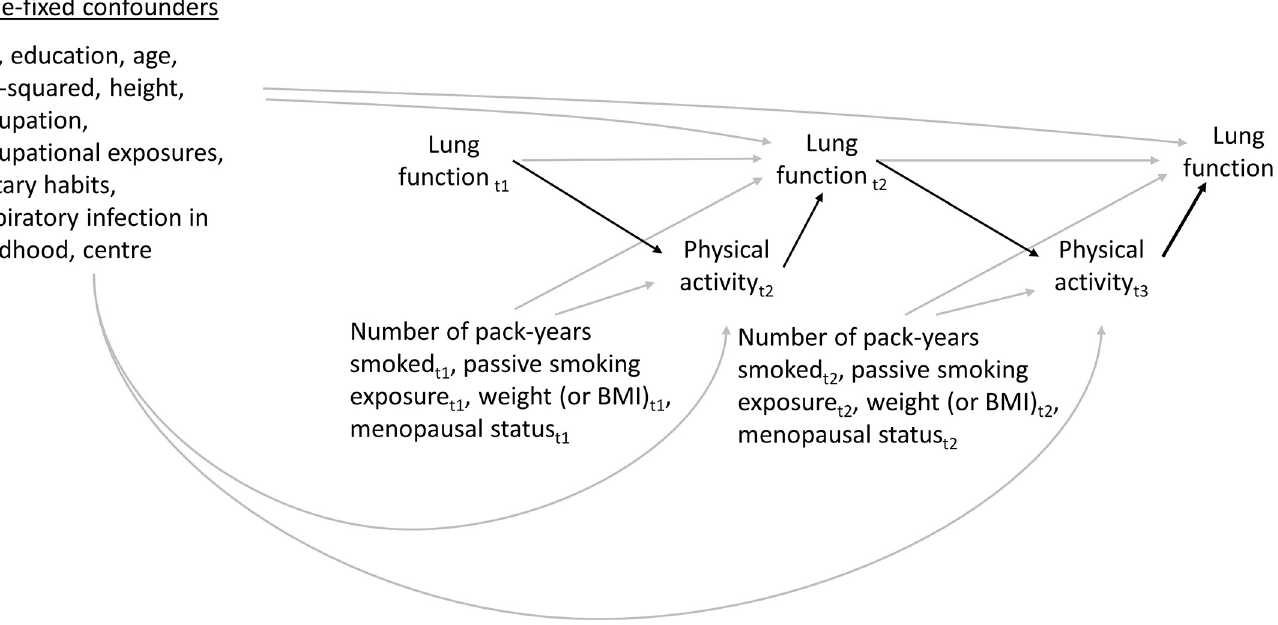
PLOS ONE | https://doi.org/10.1371/journal.pone.0237769 August 20,